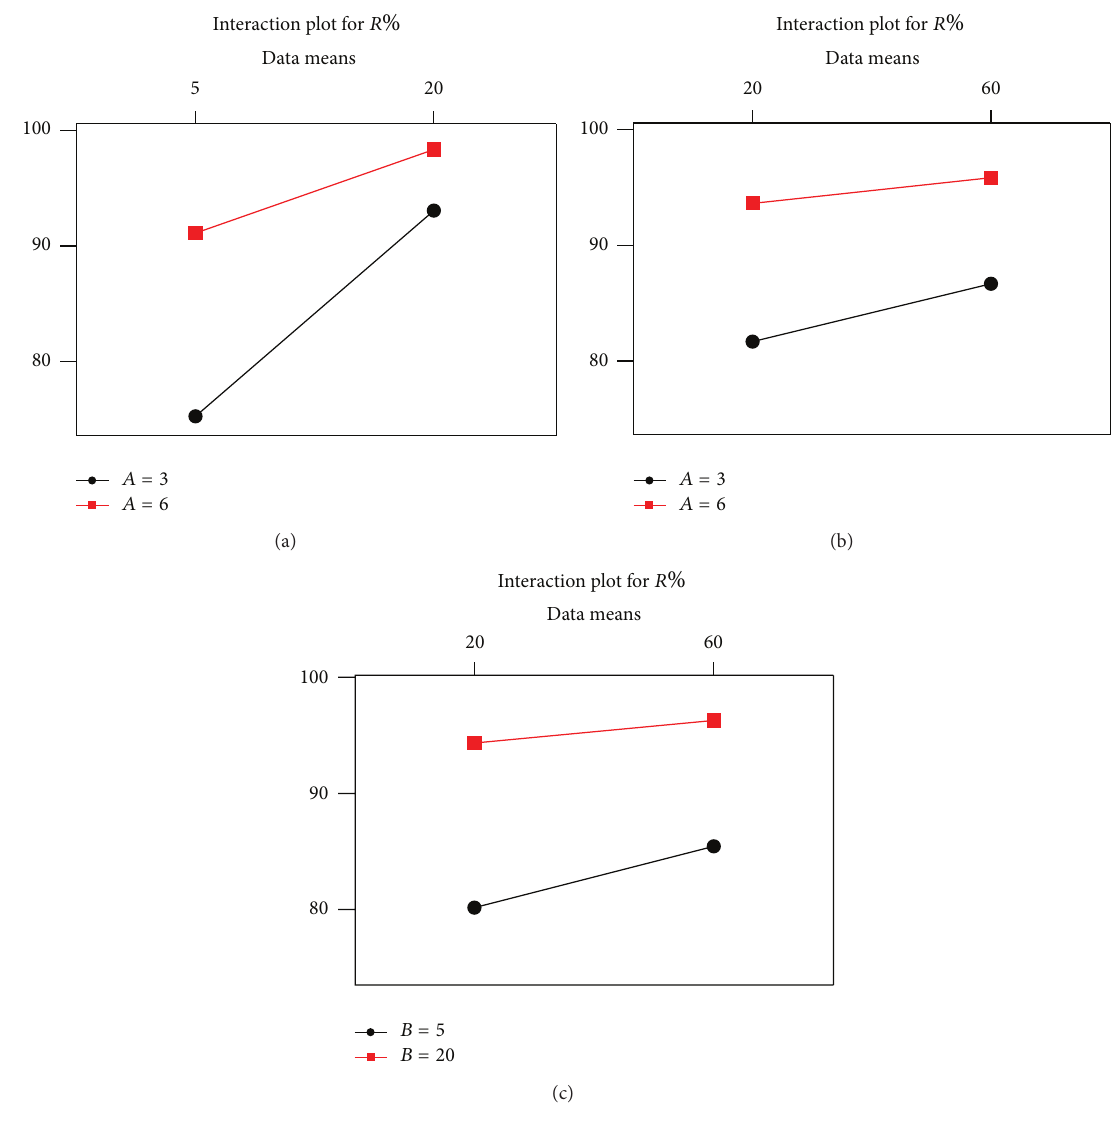
Figure 7: Interaction effects of analyzed